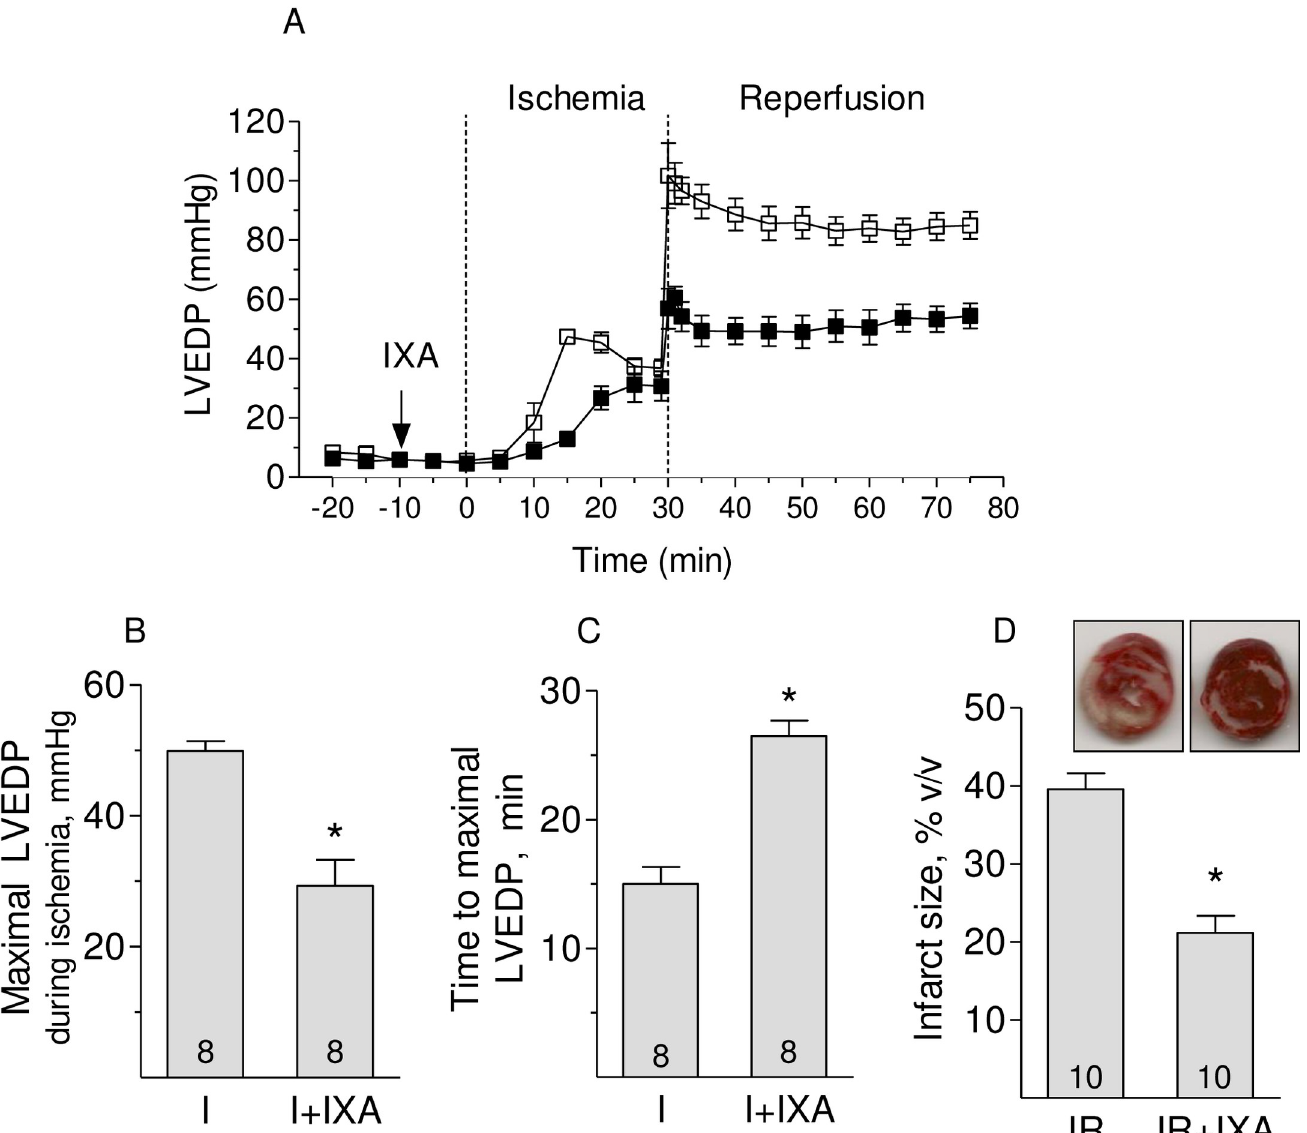
Fig 4. Effect of Ixazomib on left ventricular end-diastolic pressure and on the infarct size. (A) Left ventricular end-diastolic pressure (LVEDP) in isolated hearts during global ischemia and reperfusion in the presence (black squares) or absence (white squares) of IXA. (B) Maximal LVEDP and (C) time to maximal LVEDP during ischemia in the presence or absence of IXA were determined from records similar to the examples shown in (A) (D) Infarct size in the presence or absence of IXA. Number of hearts is shown in each bar. � p < 0.05 Student’s t test.